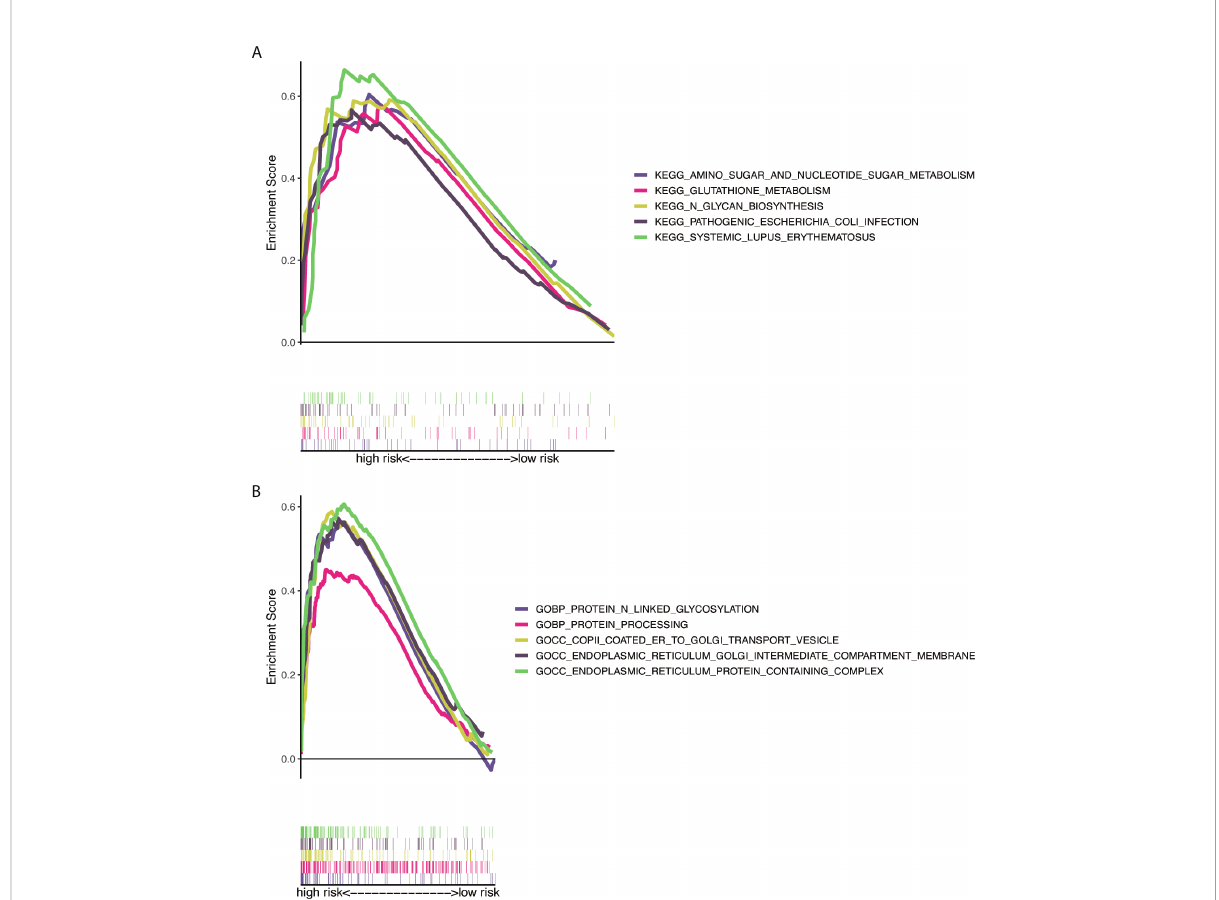
FIGURE 7 Functional and enrichment pathways analysis. (A) GO foundation enrichment analysis in the high-risk group. (B) KEGG pathway enrichment analysis in the high-risk group. GO, Gene Ontology; KEGG, Kyoto Encyclopedia of Genes and